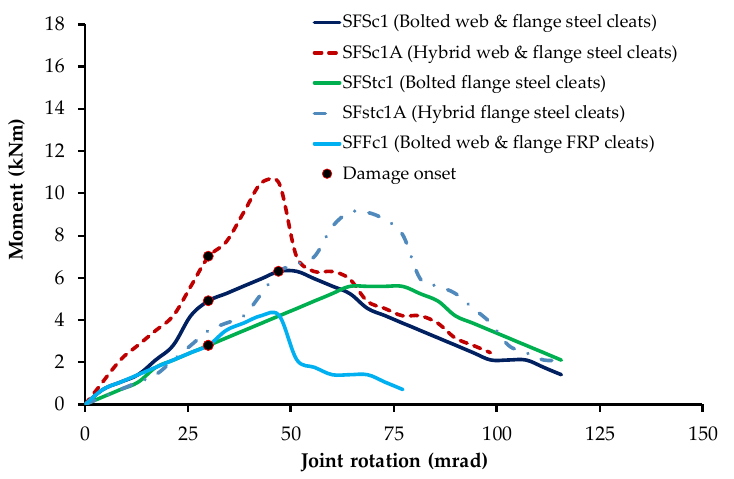
Figure 3. Moment versus rotation behaviour of beam-column joints under monotonic loading [12].